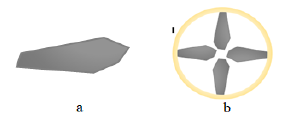
Figure 11 . a. Blade schematic. b. Rotor safety cover.